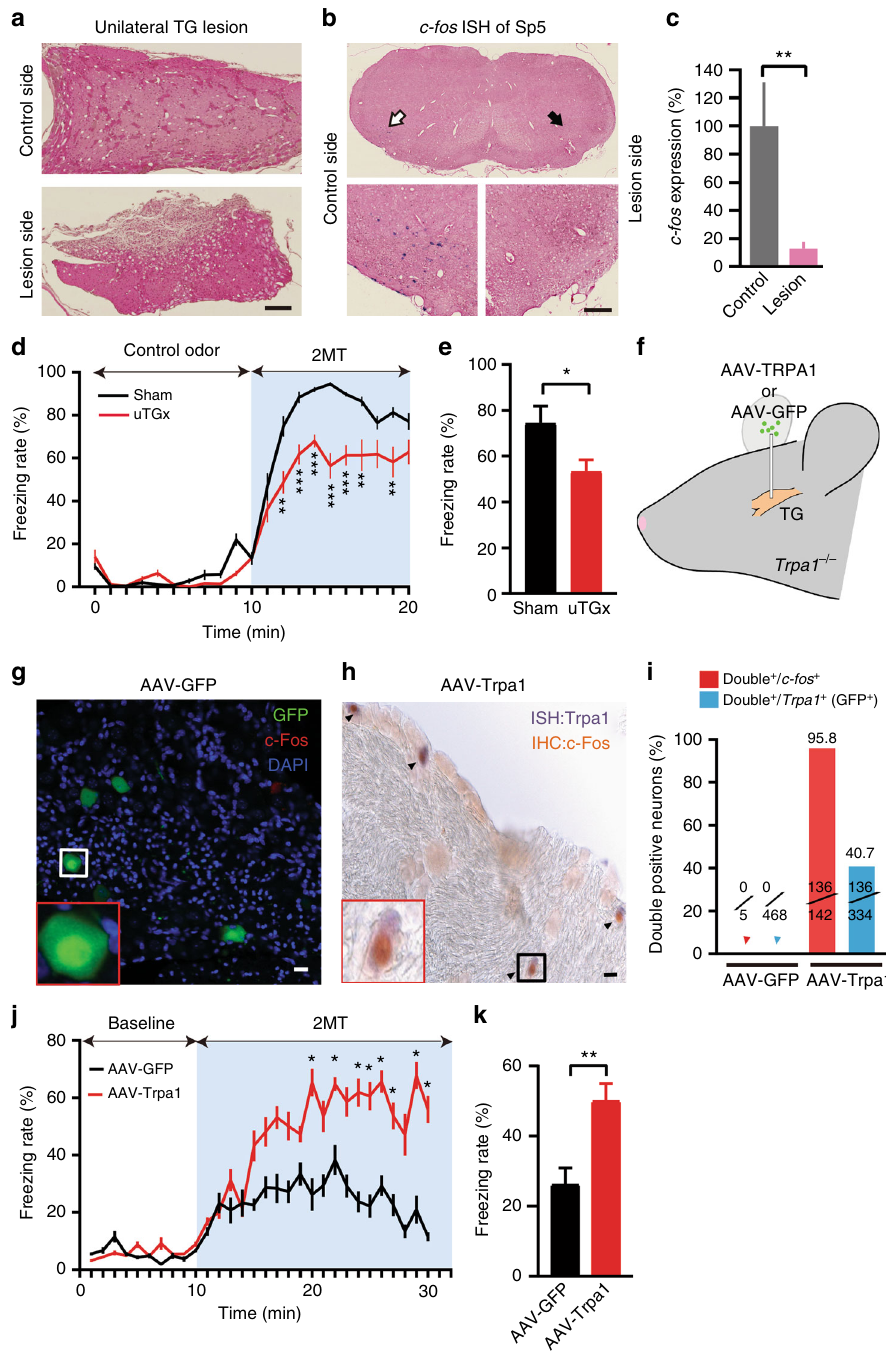
Fig. 7 Trpa1 + TG neurons contribute critically to 2MT-evoked innate freezing. a Hematoxylin and eosin staining of the control and lesioned TG of wild-type mouse after unilateral lesion (ulTGx). b Representative images showing c-fos ISH signals in the Sp5C regions of ulTGx mice after 2MT exposure. Enlarged images of the control (white arrow) and lesion sides (black arrow) are shown in the lower panels. Scale bars are 100 µ m in a and b . c Quantitative analysis of c-fos ISH signals in the Sp5C regions of the control and lesion sides of ulTGx mice after 2MT exposure. The relative measure (%) of c-fos signals of the lesion side is normalized to that of control side. Data are presented as mean ± SEM ( n = 8, Student ’ s t -test, ** P < 0.01). d Quantitative analysis of 2MT- evoked freezing behavior in the sham (black) and ulTGx (red) mice. Data are presented as mean ± SEM ( n = 8, Student ’ s t -test, ** P < 0.01, *** P < 0.001). e Quanti fi cation of average freezing rate in the sham (black) and ulTGx (red) mice during 10 min of 2MT treatment. Data are presented as mean ± SEM ( n = 8, Student ’ s t -test, * P < 0.05). f A schematic of bilateral injection of AAV-GFP or AAV-Trpa1 into the TG of Trpa1 − / − mice. g Representative IHC images of AAV-GFP-infected TG sections of Trpa1 − / − mice. GFP (green); c-Fos (red); DAPI (blue). h Representative images of double Trpa1 /c-Fos staining of AAV- Trpa1-infected TG sections of Trpa1 − / − mice. Trpa1 ISH (purple); c-Fos IHC (brown). Arrowheads indicate Trpa1 + /c-Fos + TG neurons. Insets are high magni fi cation images. Scale bar is 20 µ m. i Quantitation of 2MT-evoked GFP + , c-Fos + , or Trpa1 + /c-Fos + TG double positive neurons in AAV-GFP or AAV- Trpa1-infected TG, respectively. j , k Quantitative analysis of 2MT-evoked freezing behavior in the AAV-GFP (blue) and AAV-Trpa1 (red)-injected mice. Data are presented as mean ± SEM ( n = 6, Student ’ s t -test, * P < 0.05; ** P <